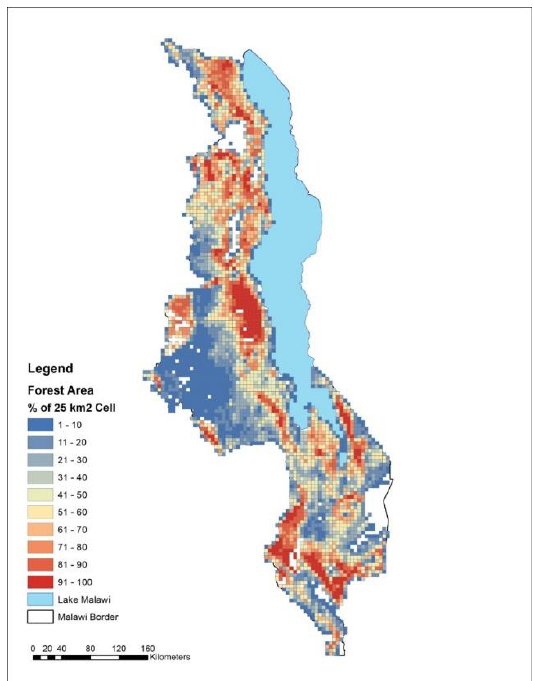
Figure 4. Mapping of forest cover density aggregated to 25 km 2 grid cells. Forest area is represented as a proportion (%) of each 25 km 2 grid cell, from low values in blue to high values in red. The data are produced at 30 m resolution, and a large dataset at that resolution is available for the entire country. Aggregation is used for display at this scale.